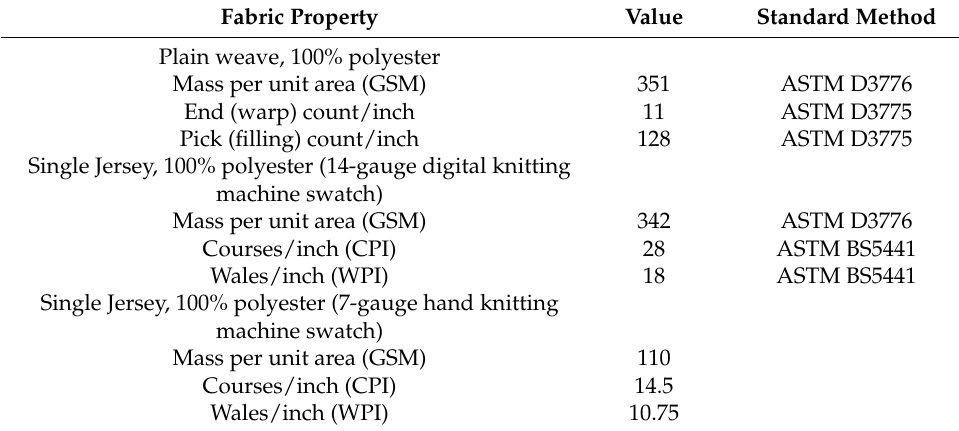
Table 1. Fabric specifications and corresponding standards